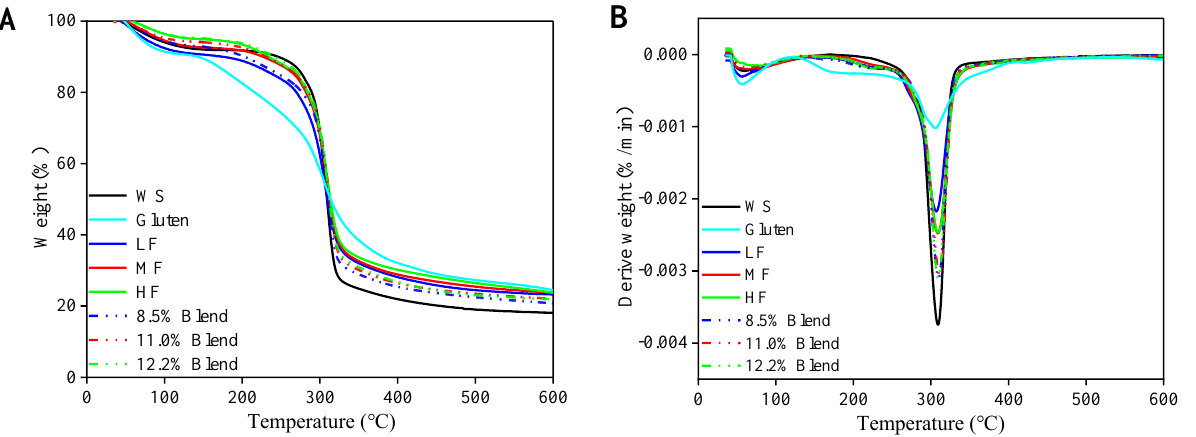
Figure 9. TGA curves ( A ) and DTG curves ( B ) for the films of pure WS, wheat flours, and WS–gluten blends with different protein contents (8.5%, 11.0%, and 12.2%).